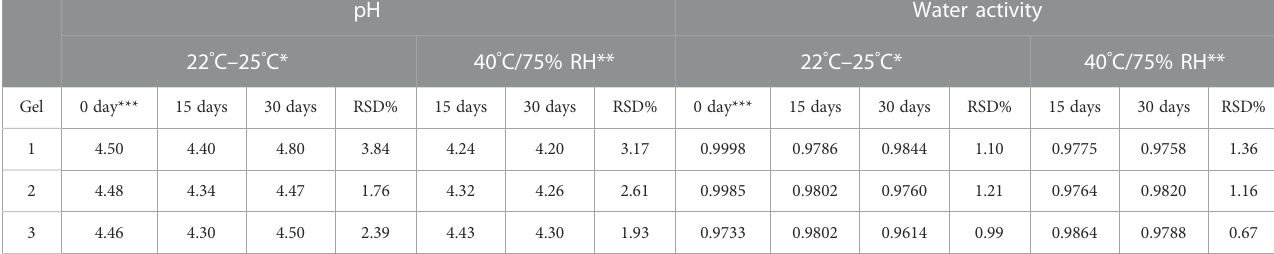
TFC (milligram of quercetin/g in 1 g of gel formulation)